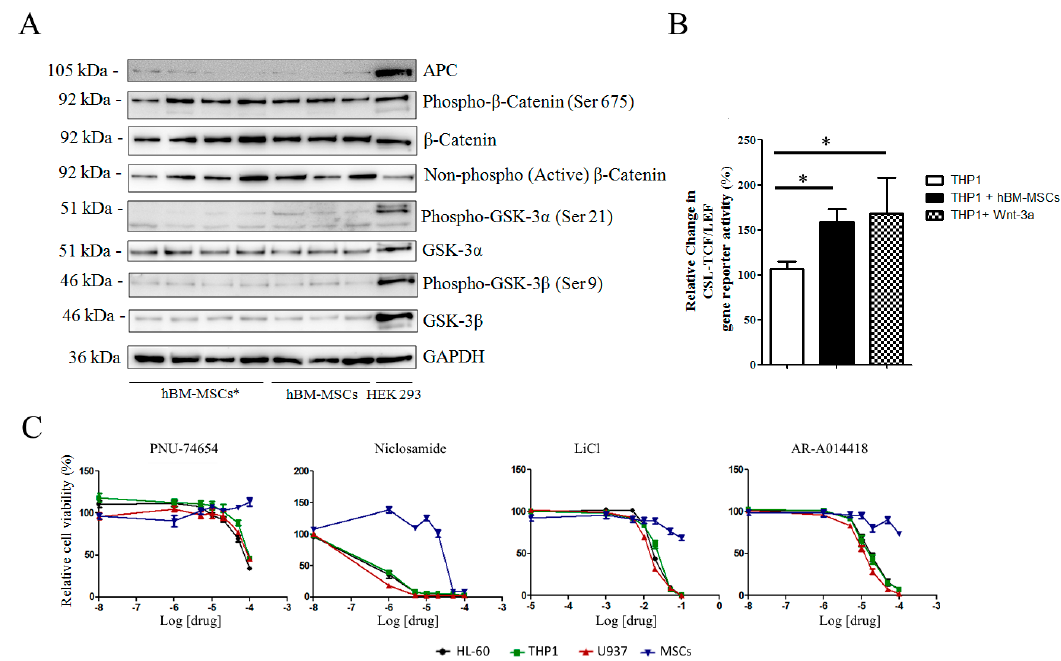
Figure 5. Expression of Wnt and GSK-3 molecules in hBM-MSCs. ( A ) Representative Western blot analysis (Figure S3) of Wnt components in AML-hBM-MSC (hBM-MSCs *) and hBM-MSCs from